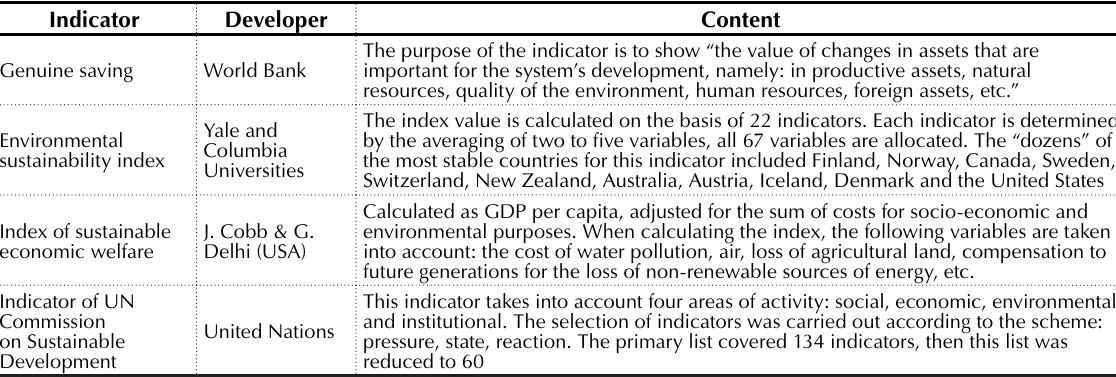
Table 1. Indicators for assessing the sustainability of the state’s